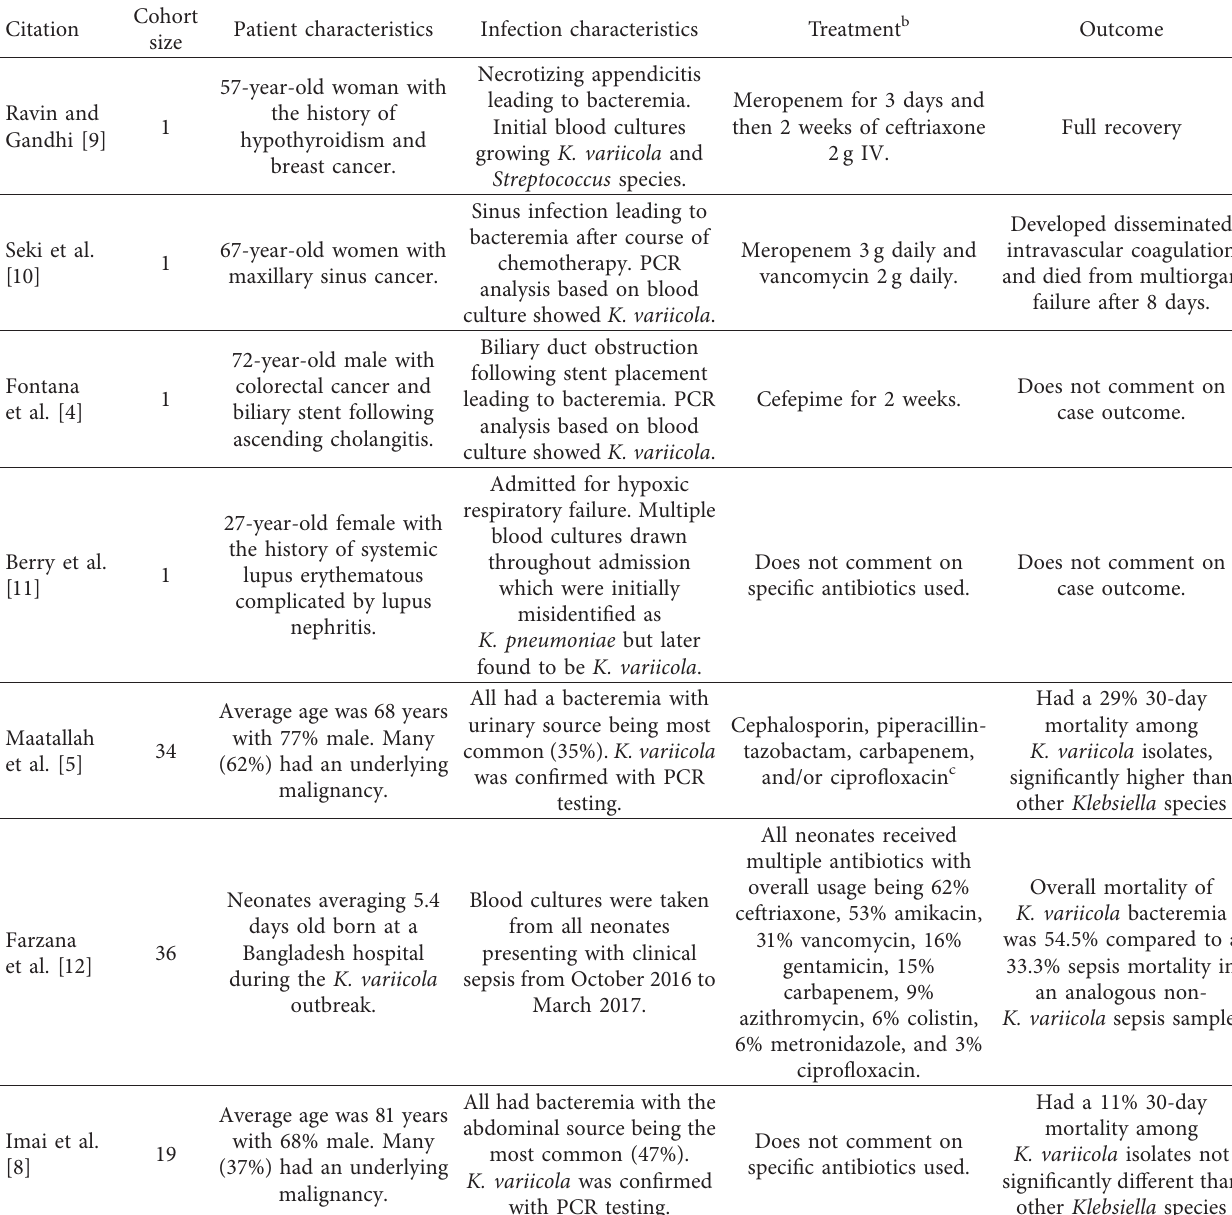
Table 1: Review of literature on Klebsiella variicola a